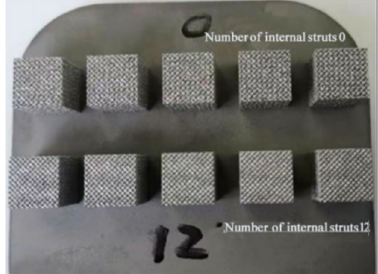
Table 6. Comparison of calculated and experimental values.